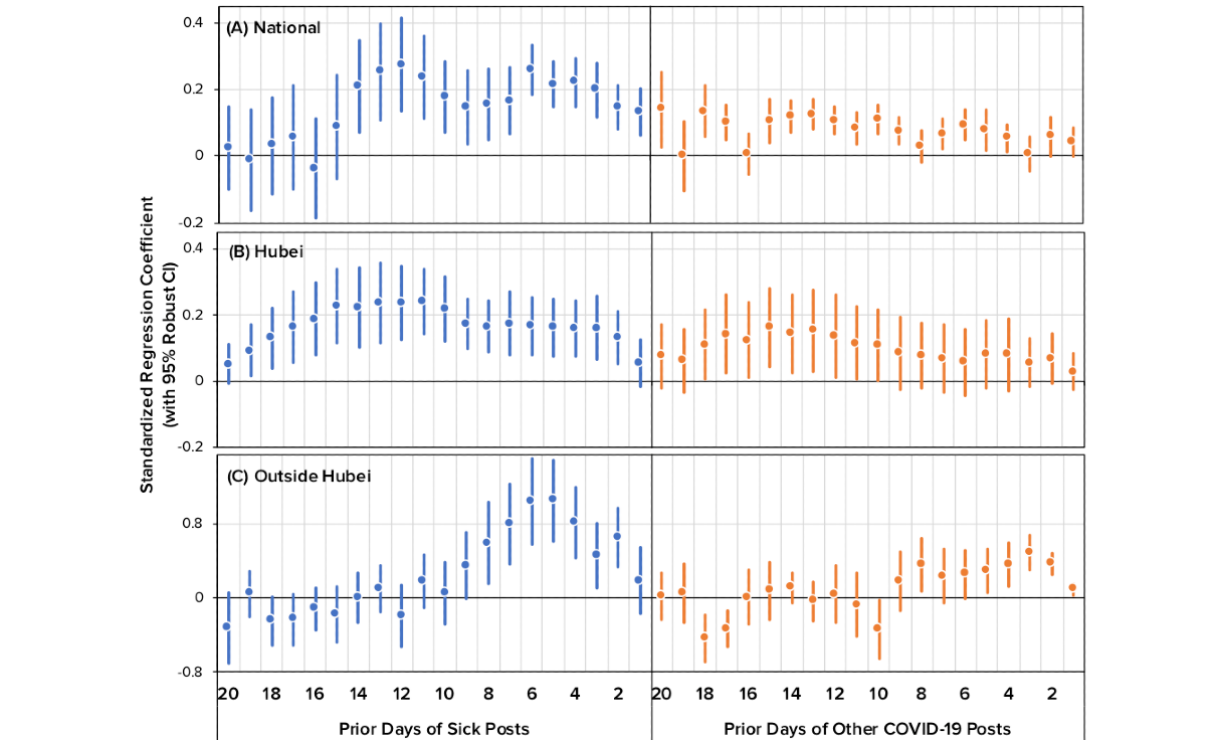
Figure 4. Standardized estimates of Granger causality for time-lagged, daily-additional Weibo posts (sick posts and other COVID-19 posts) predicting daily-additional